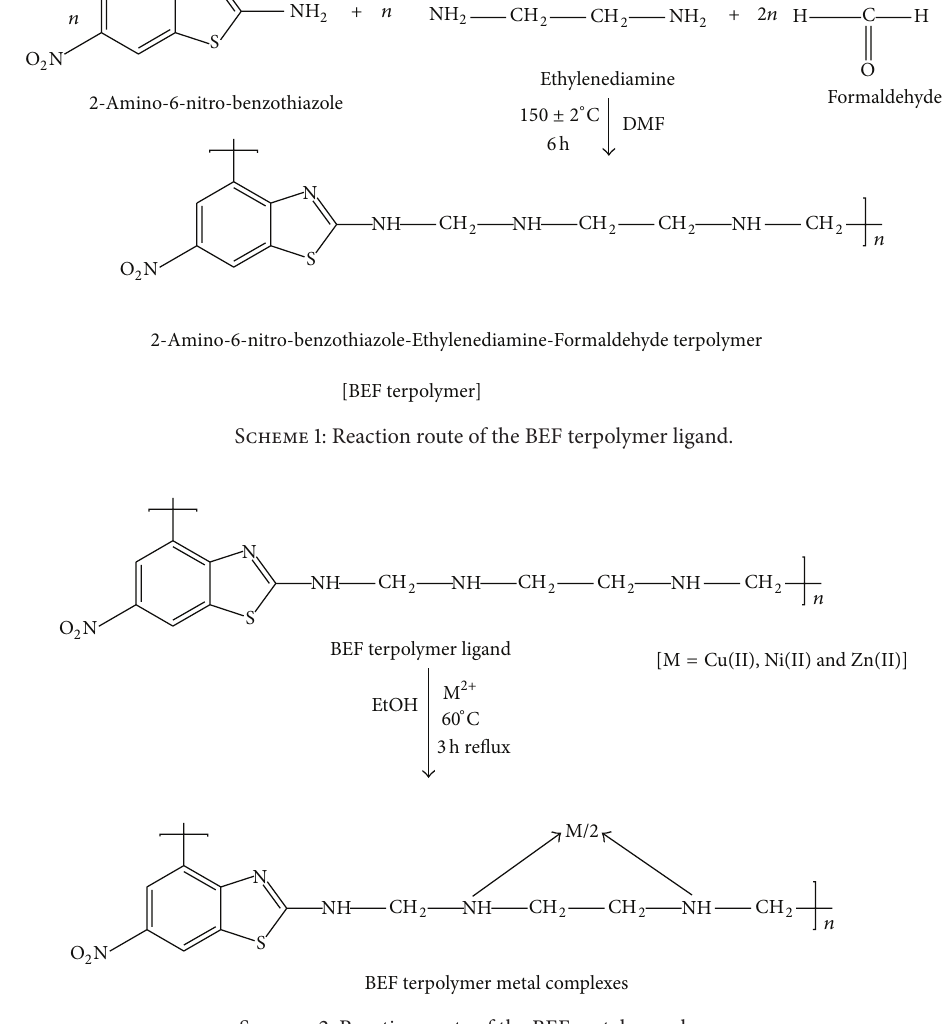
Scheme 2: Reaction route of the BEF metal